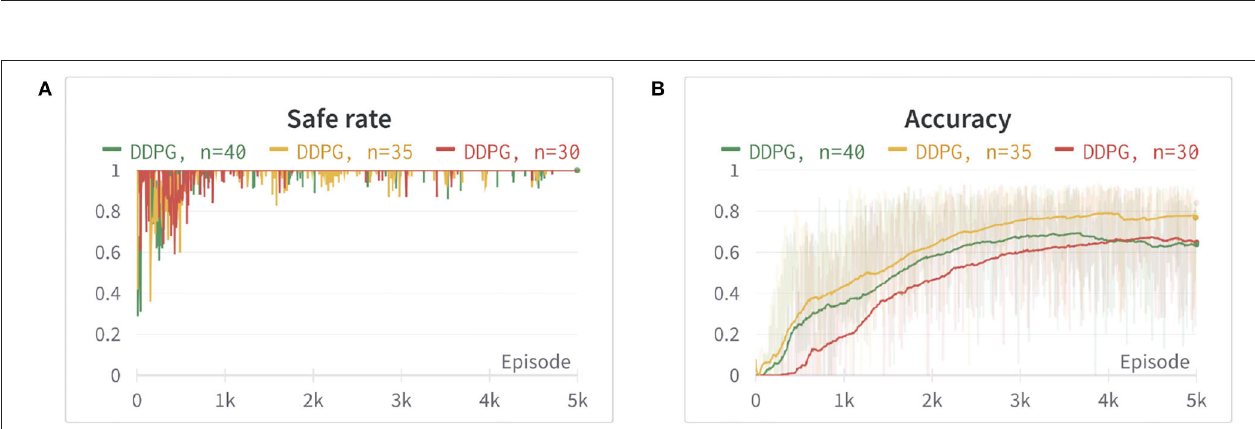
FIGURE 1 | The comparison of two different observation spaces set up in the first environment. Both are using soft actor-critic (SAC) and with the same hyperparameters setting. The orange line is the result using relative position and velocity in observation space, whereas the blue line is using position and velocity. (A) The safe rate (defined in Section 4.2) of different observation spaces. (B) The accuracy (defined in Section 4.2) of different observation spaces. Each episode corresponds to 100 time steps.